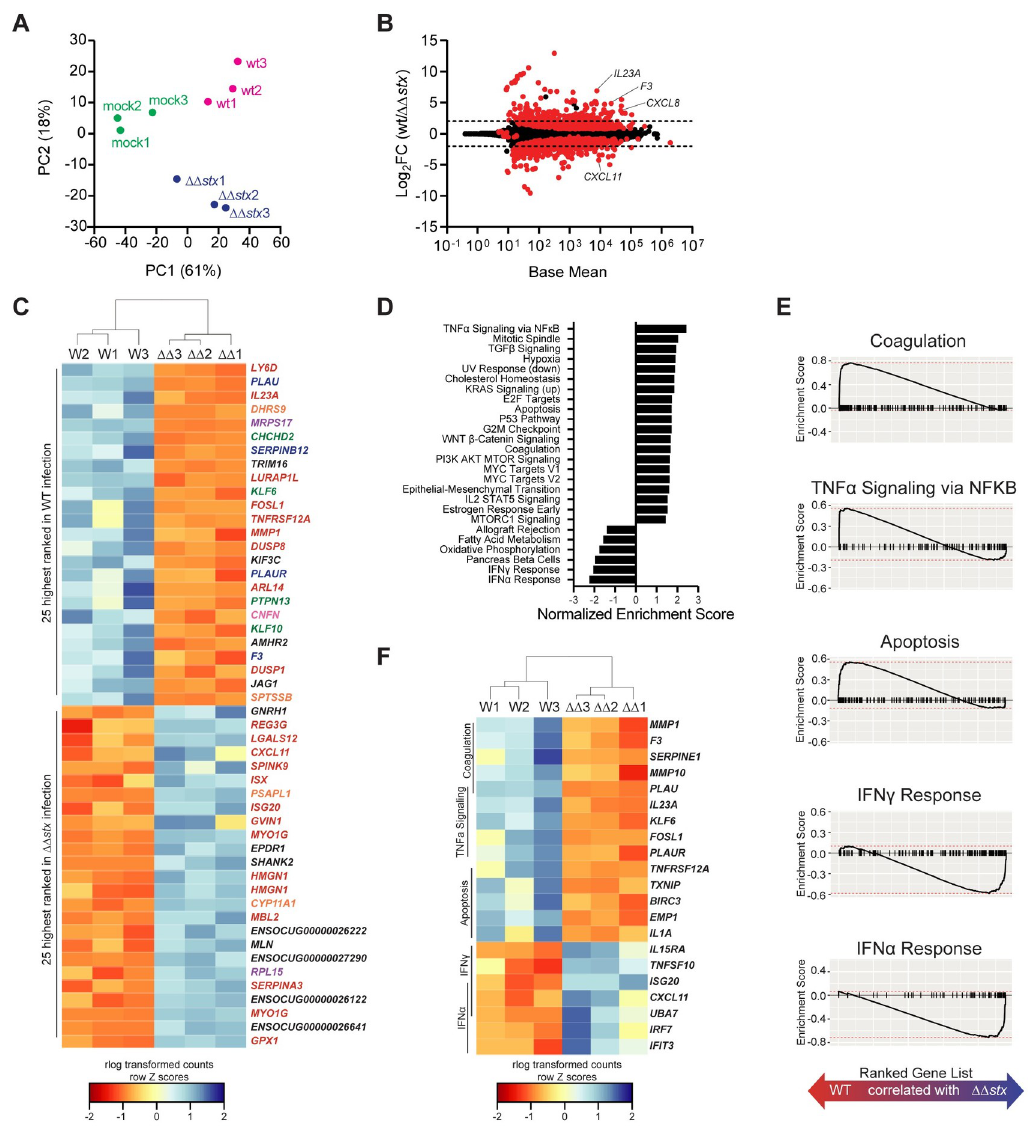
Fig 2. Profiles of colonic epithelial cell transcriptional responses differ between animals infected with WT and ΔΔ stx EHEC. (A) Principal component analysis of rlog-transformed expression values. (B) Average expression level (base mean) and log2 fold change of transcript abundance from rabbits inoculated with WT or ΔΔ stx EHEC. Red dots are genes with significantly different (p < 0.05) transcript abundance. Dashed line indicates log2 fold change > 2 or < -2. (C) Heat map of rlog-transformed read counts for top 25 and bottom 25 genes by rank. Rows are Z-normalized. Gene names are colored by function: red–immune, orange–metabolism, green–proliferation/apoptosis, blue–coagulation, purple–translation/protein folding, pink–barrier function/cytoskeleton, black–uncharacterized or other. (D) Hallmark gene sets significantly associated with WT or ΔΔ stx infection. (E) Gene set enrichment plot for selected pathways. Black tick marks are genes within pathway organized by rank. (F) Heat map of rlog-transformed read counts for top 5 genes in the leading edge for indicated pathway organized by rank.